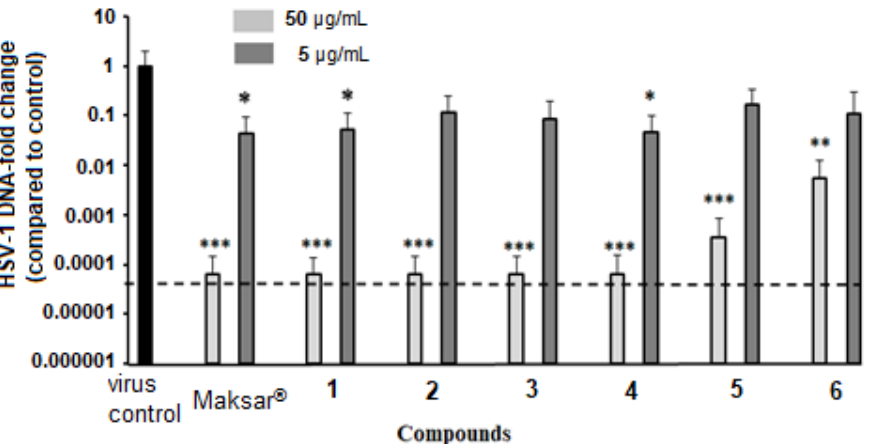
Figure 5. Anti-HSV-1 activity of polyphenolic compounds from M. amurensis (RT-PCR). The tested compounds at concentrations of 50 µ g/mL and 5 µ g/mL were added to Vero cells simultaneously with the virus. The relative changes in HSV-1 DNA levels were calculated using the 2 − ∆ Ct method and reported as the fold reduction relative to virus control (control = 1). The dashed line represents DMSO-treated cells (cell control). Data are expressed as means ± SD of three independent experiments. (*), (**), (***) indicated significant difference versus PQ-treated cells ( p < 0.05, p < 0.01, p < 0.001).